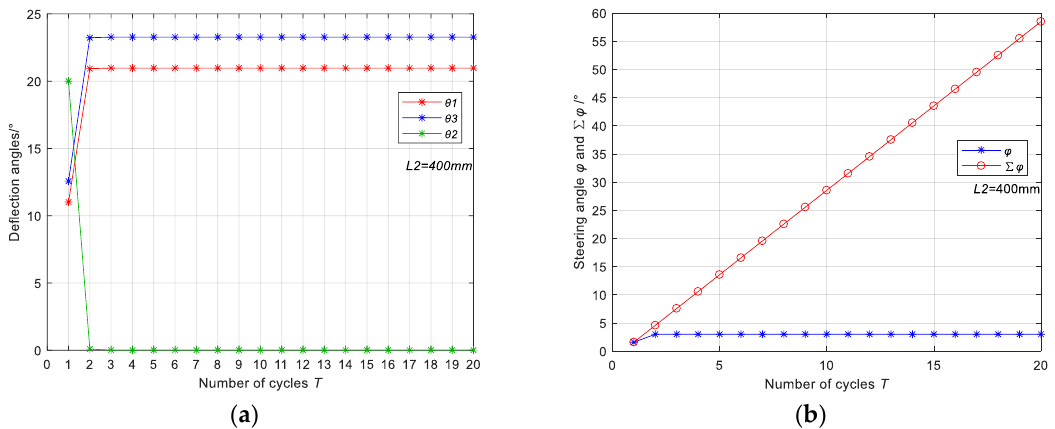
Figure 11. The relationship between the values of θ 1 , θ 2 , θ 3 , and ϕ at the end of Phase 1 and the number of cycles T (at the initial phase: L 2 = 400 mm, θ 2 = 20 ◦ ): ( a ) The curve of θ 1 , θ 2 , and θ 3 changing with the number of cycles T; ( b ) the curve of steering angle ϕ and cumulative steering angle ∑𝜑 changing with the number of cycles T.